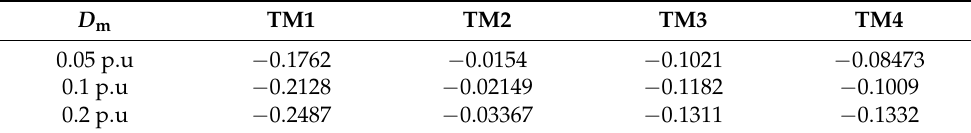
Table 6. Damping coefficient for TM1–TM4 of SG under different T A ( K A = 50).